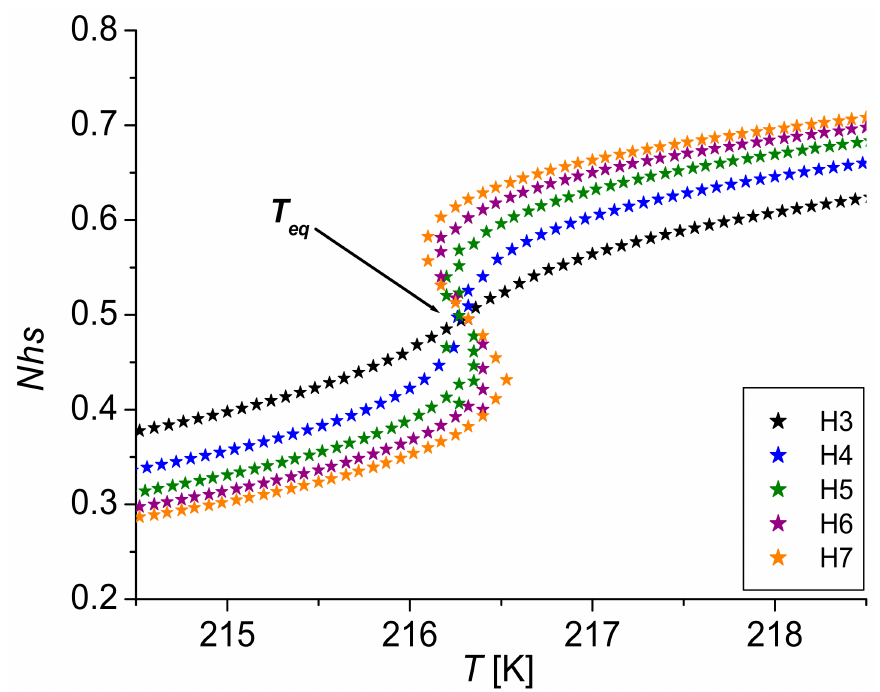
Figure 2. Thermal evolution of the HS molar fraction for different lattice sizes in the 2D hexagonal lattice. Black stars: H3 (19 atoms); blue stars: H4 (37 atoms); green stars: H5 (61 atoms); purple stars: H6 (91 atoms); and orange stars: H7 (127 atoms). The computational parameters were: ∆ / k B = 1300 K, J/k B = 30.20 K, G/k B = 49.70 K, L/k B = 0 K, and ln ( g ) =